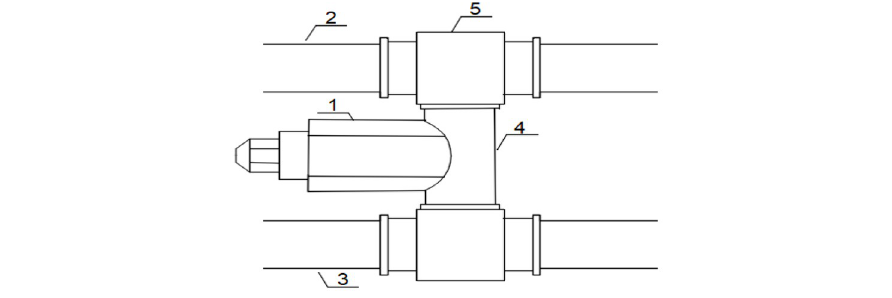
Fig 2. Schematic diagram of the nozzle